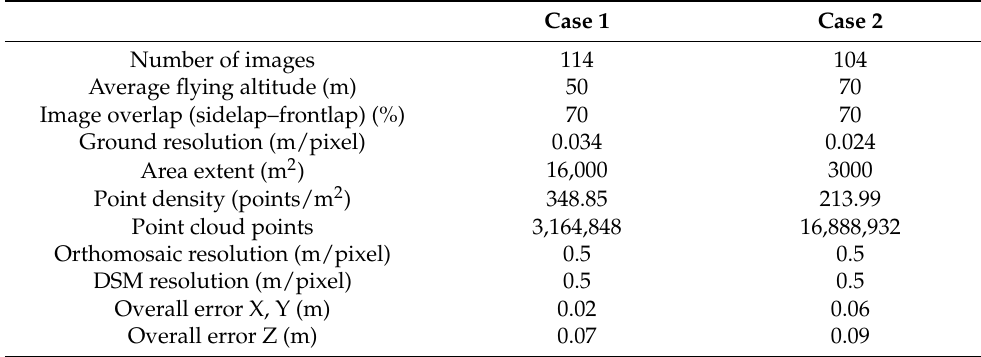
Table 1. Technical details of the UAV missions for the acquisition of each